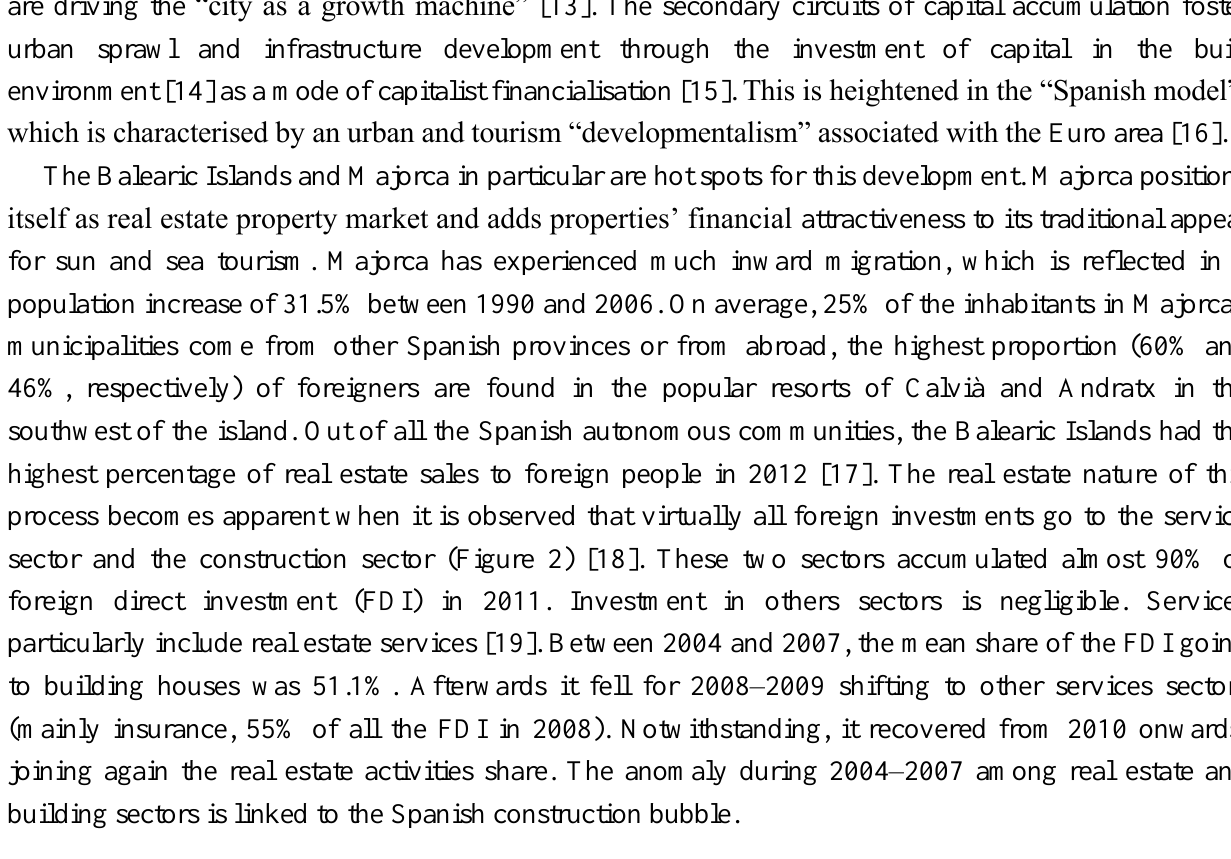
Figure 2. Development of foreign investment in the Balearic Islands and the importance